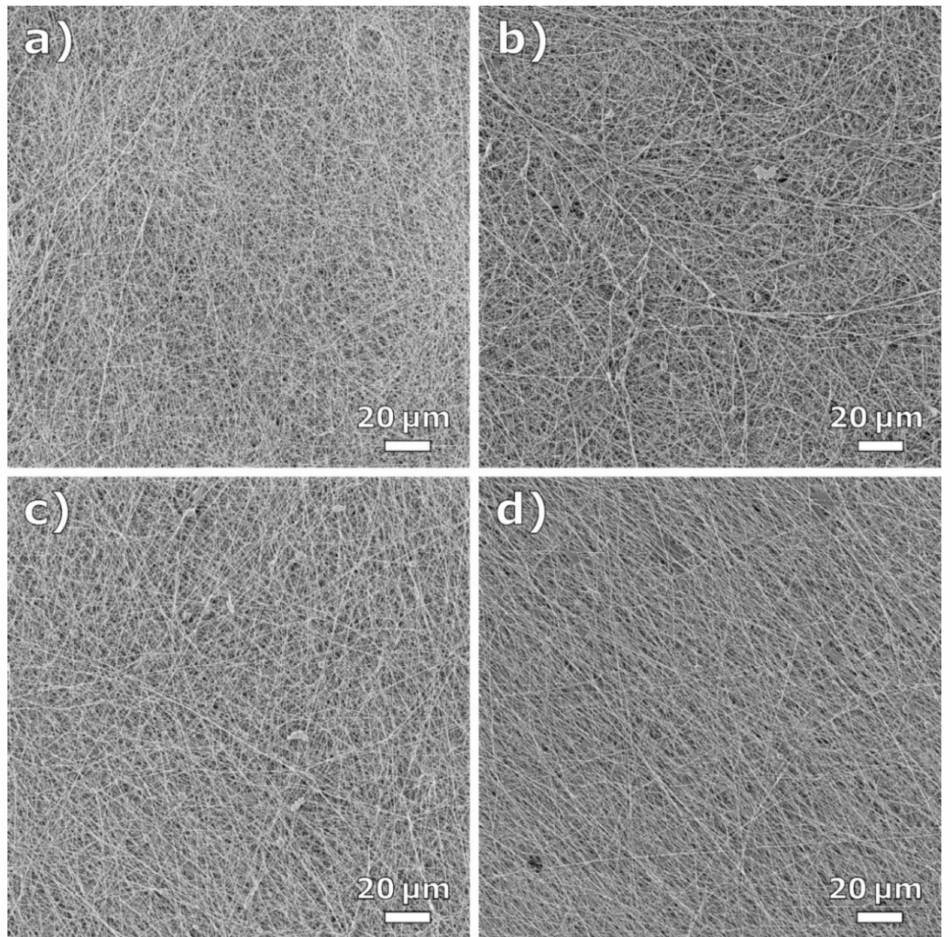
Figure 3. HIM images with larger fields of view of the nanofibers on ( a ) Ag–Cu flakes/graphite, ( b ) carbon black/PEDOT:PSS, ( c ) TiO 2 /ITO and ( d ) TiO 2